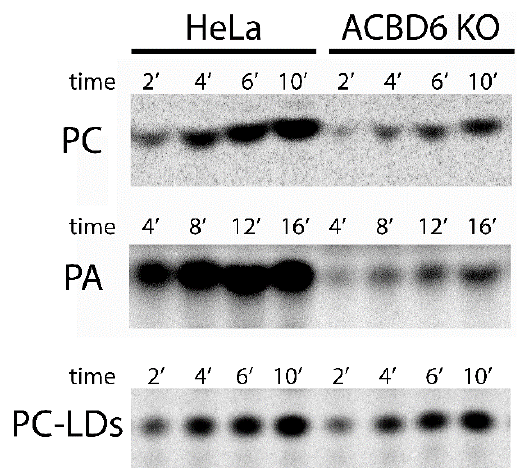
Figure 7. Analysis of the acyl-CoA dependent acylation of lysoPA and lysoPC. Products of the reactions presented in Figures 6 and 8 were separated by thin-layer chromatography as previously described [51] . Formation of PC and of PA by lysates of ACBD6.KO and HeLa are shown in the top and middle panels, respectively. Formation of PC by lipid droplets (LDs) isolated from ACBD6.KO and HeLa is presented in the bottom panel.